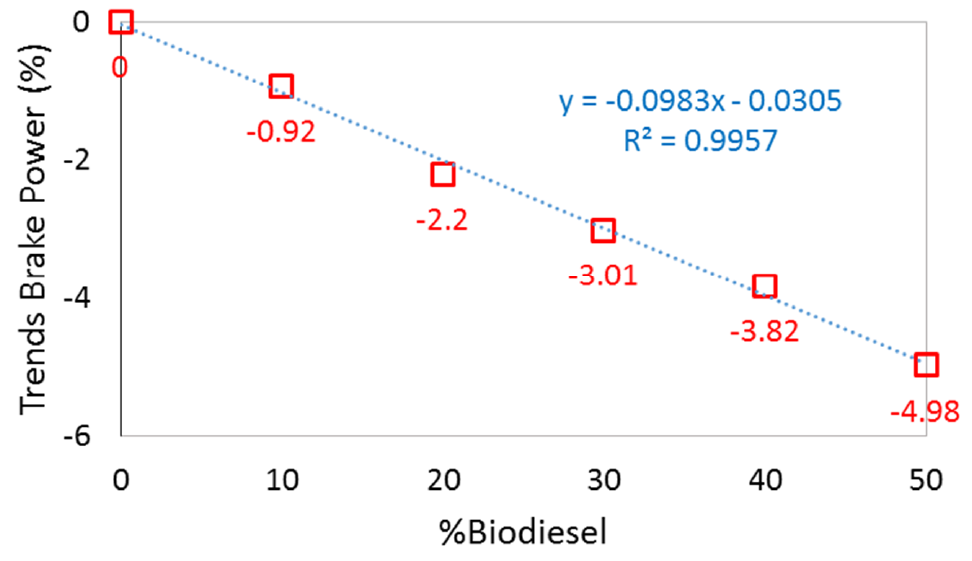
Figure 4. Trending Engine power follows biodiesel blends.